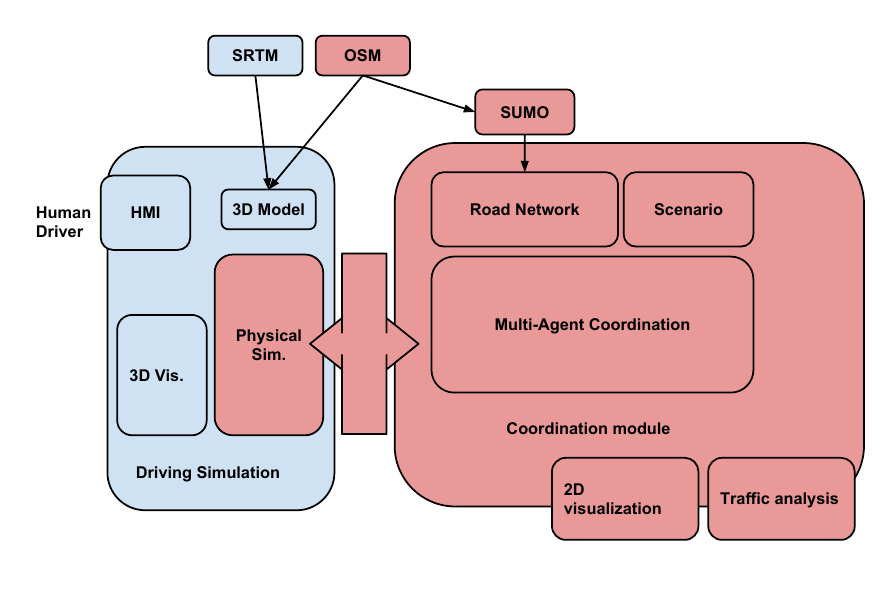
Figure 2. Simulation platform architecture, the Driving Simulation module represents OpenDS part and the module on right is the AgentDrive platform. Note, we use OpenStreetMap data for the road traffic